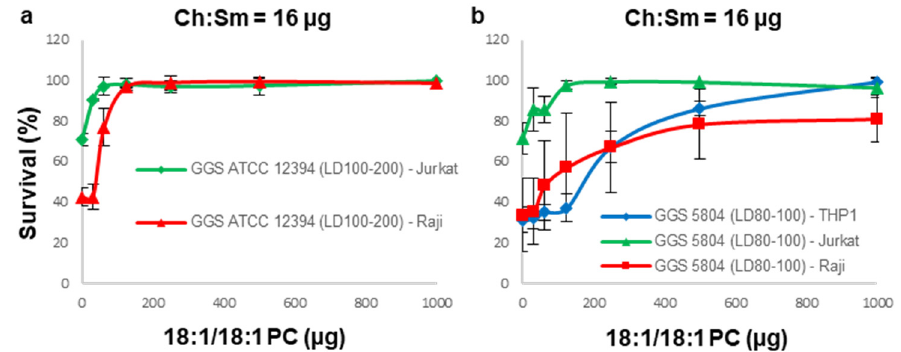
Figure 4. Inhibition of the cytolysins secreted by GGS by a liposomal mixture composed of Ch:Sm and 18:1/18:1 PC-liposomes. The combination of Ch:Sm-liposomes with 18:1/18:1 PC-liposomes com- pletely protects immune cells against GGS ATCC 12394 cytolysins ( a ). Against GGS 5804